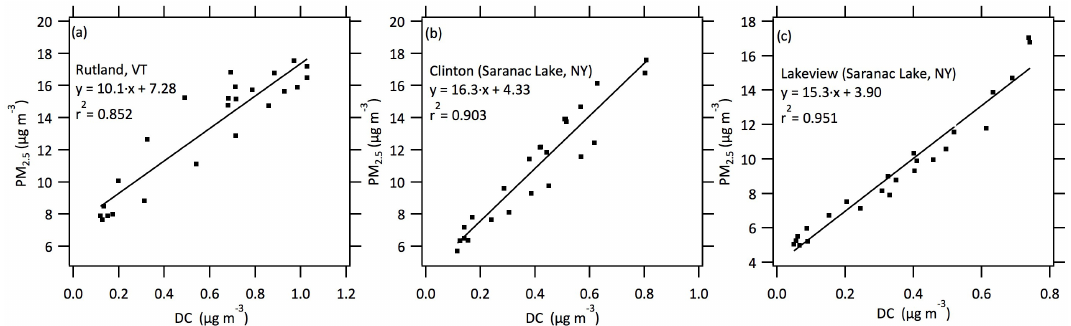
Figure 6. Diurnal PM 2 . 5 vs. DC (i.e., BC (370nm) − BC (880nm)) averaged over the wintertime operation periods for (a) the Rutland site, and over the entire operation periods for (b) the Clinton site and (c) the Lakeview site, respectively, into